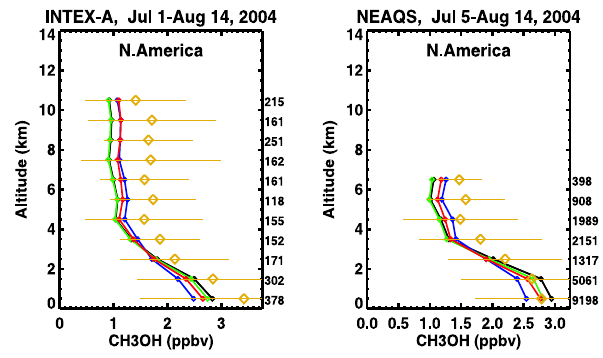
Fig. 14. Comparison between vertical profiles measured during the INTEX-A and NEAQS aircraft missions and inferred from the OptS2 (black lines), OptS2-conv (blue), OptS2-drydep (green), and OptS2-OH (red).